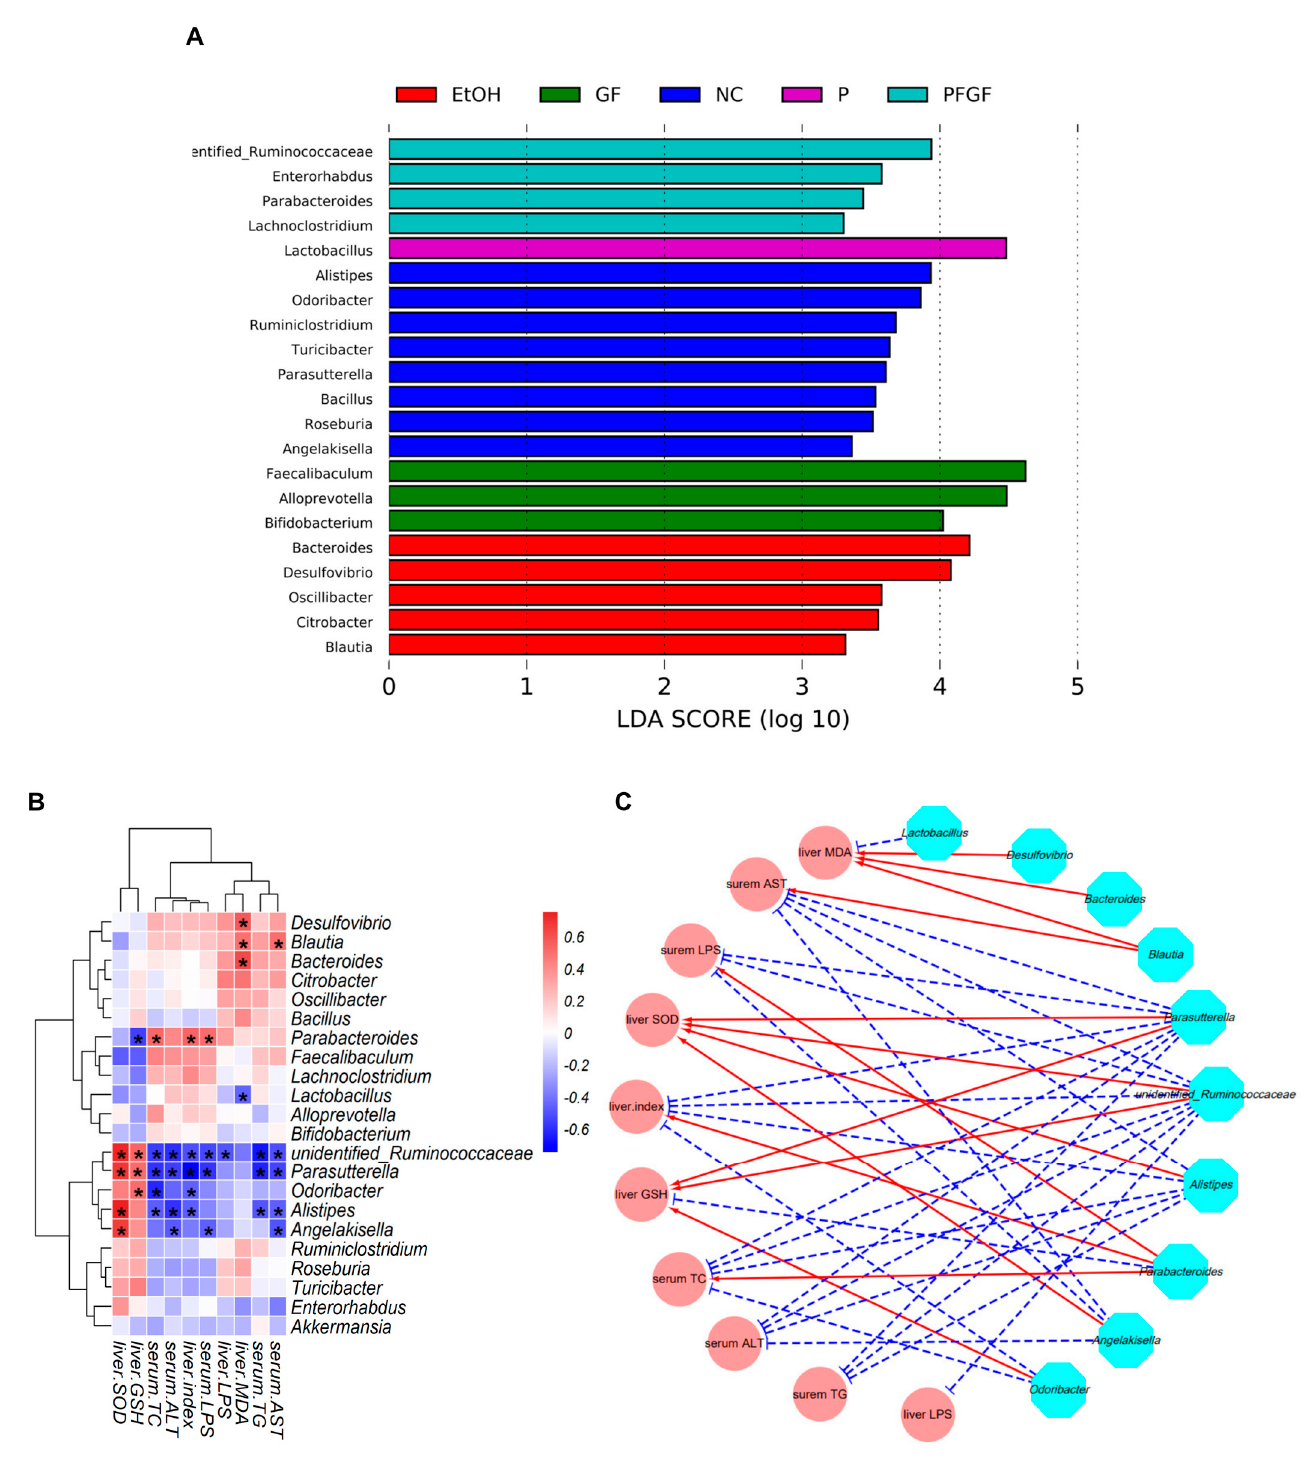
Figure 5. LEfSe analysis of intestinal microbiota at genus-level among NC, EtOH, P, GF, and PFGF groups ( A ). Heatmap of correlations between significant different intestinal microbiota and biochemical parameters ( B ); * indicates Spearman’s rank correlation coefficient > 0.5 or < -0.5. Visualization of correlation network. Cyan nodes: intestinal microbial genera; pink nodes: parameters; red lines: Spearman’s rank correlation coefficient > 0.5, adjusted p < 0.01; blue lines: Spearman’s rank correlation coefficient < -0.5, adjusted p < 0.01 ( C ). A heatmap of the correlations between the significantly different intestinal microbi- ota and biochemical parameters and a visualization of the correlation network are shown